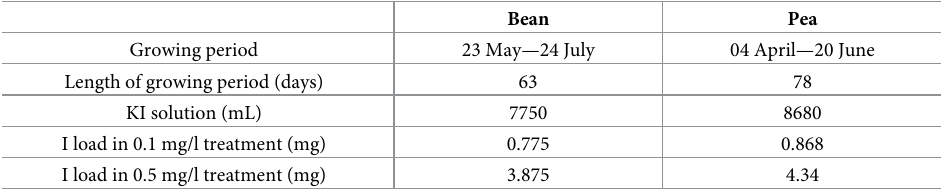
Table 3. Irrigation and growing parameters of bean and pea